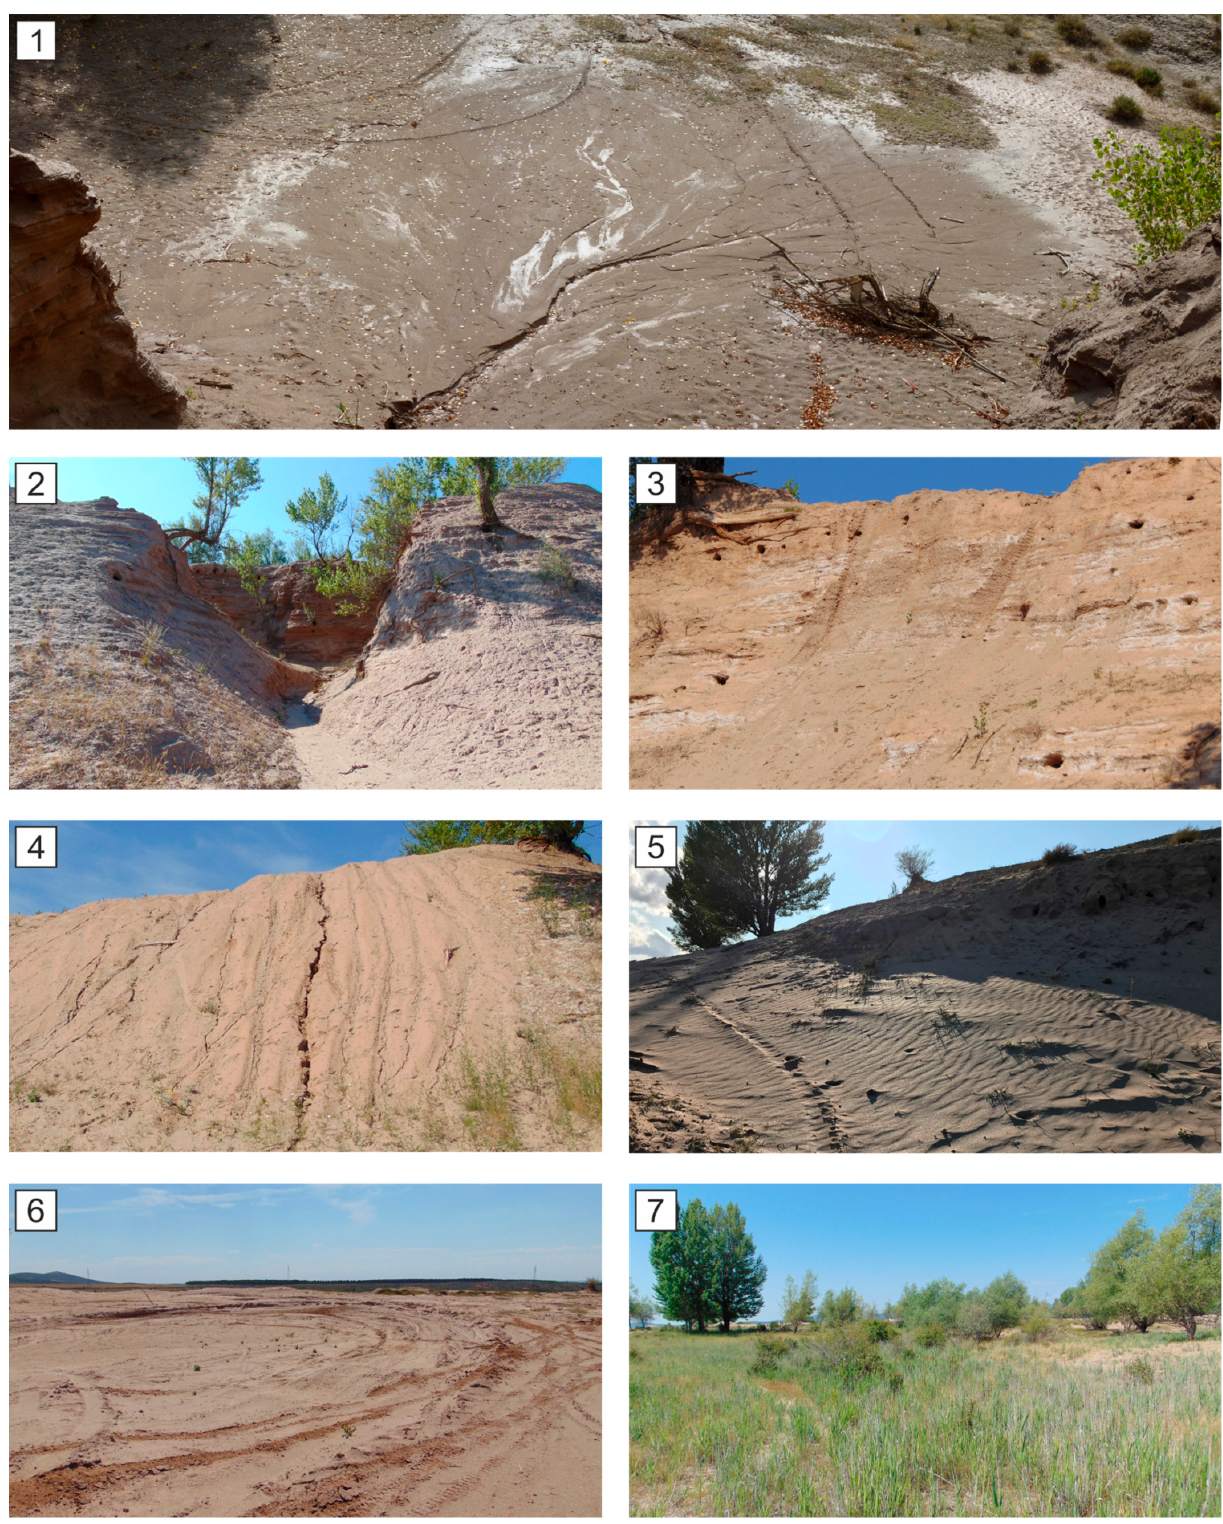
Figure 4. Landforms on the ponds. The numbering of each photograph corresponds to the photo- graph points in Figure 3. 1: Alluvial cone at the mouth of the westernmost gully of the north pond. 2: North pond gully. 3: Saline efflorescence, exposed roots, motorbike tracks and excavated nests on a hillside of the north pond. 4: Rill erosion over motorbike tracks on a hillside of the south pond. 5: Ripples on the eolian mantle that developed over colluvium of the south pond. 6: Crescent-shaped tracks and mounds due to motorbike racing in the south pond. 7: Vegetation cover in the temporary flooded area of the south